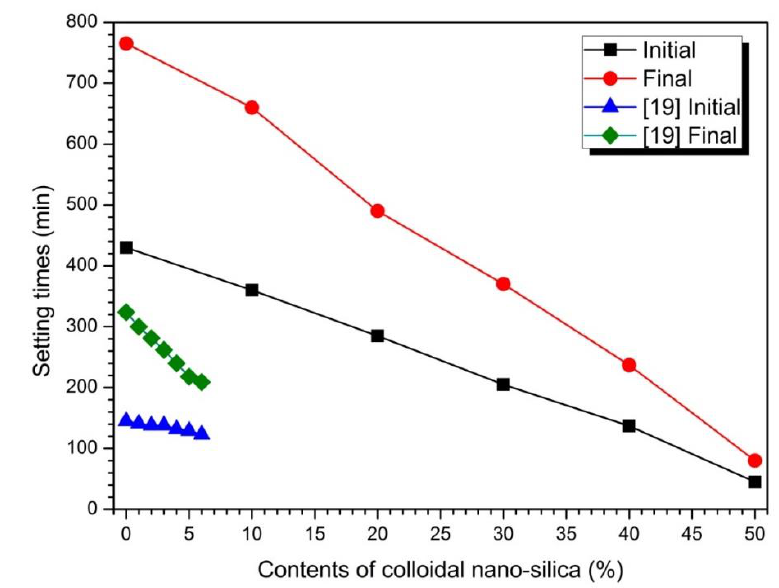
Figure 2. Setting time of the CNS replacement rate.